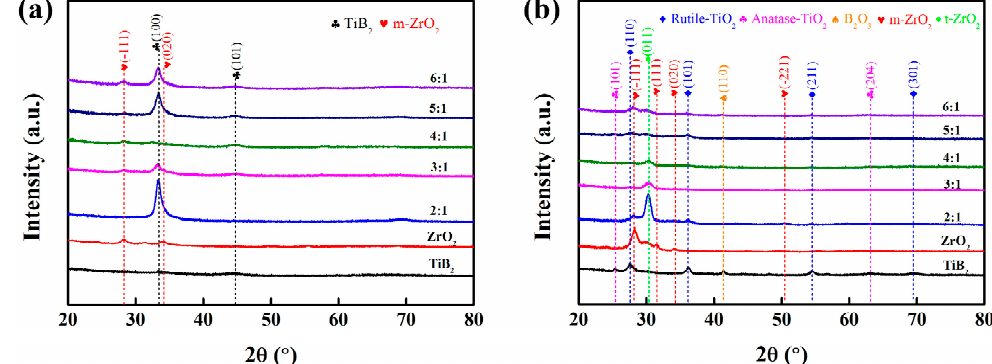
Figure 1. The XRD patterns of the TiB 2 and ZrO 2 monolayers along with the TiB 2 /ZrO 2 multilayers with different t TiB ₂ : t ZrO ₂ before ( a ) and after annealing at 600 °C for 1 h ( b